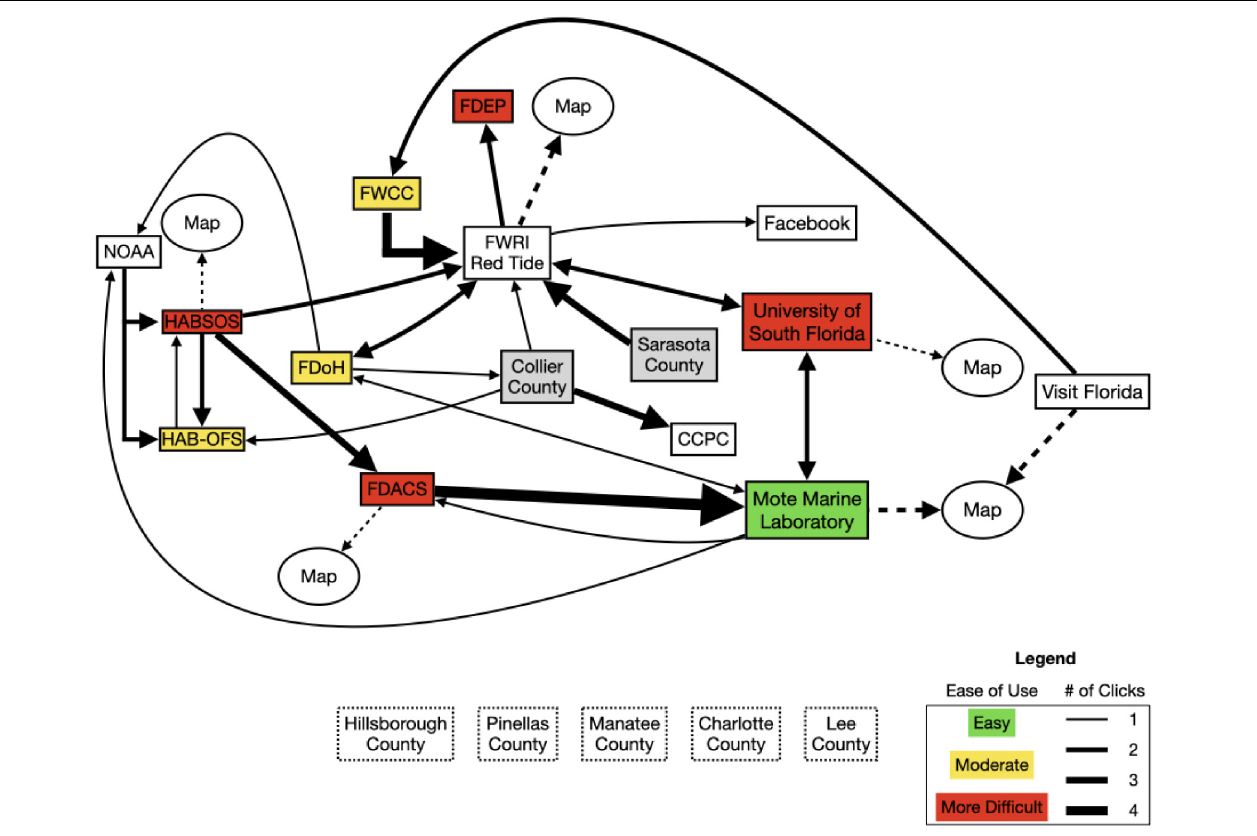
FIGURE 2 | The complexity of links among webpages providing information of various types about Florida red tides (as of July 2019). The thickness of the lines indicates the number of mouse clicks required to get from one page to another. The dotted lines point to maps. Information at each node is variable and tailored for different audiences (see examples in Table 1 ). Dotted boxes represent counties affected by Florida red tide that do not interface with any of the websites. FWCC, Florida Fish and Wildlife Conservation Commission; FWRI, Florida Wildlife Research Institute; FDOH, Florida Department of Health; FDEP, Florida Department of Environmental Protection; FDACS, Florida Department of Agriculture and Consumer Services; FPCC, Florida Poison Control Center; HABSOS, Harmful Algal Blooms Observing System; HAB-OFS, Harmful Algal Bloom Operational Forecast System; USF, University of South Florida; MML, Mote Marine